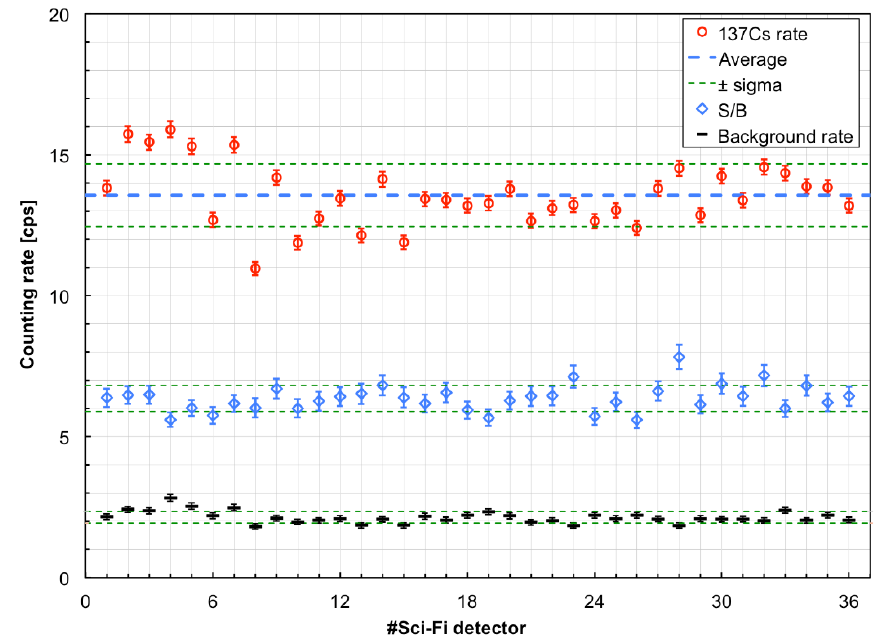
Figure 13. The counting rate of the 36 SciFi detectors, measured with the 137 Cs source in 200 s in the setup of Figure 12, along with the background rate and the signal-to-background ratio. The error bars represent the statistical uncertainty, the green dashed lines indicate ±1 standard devia- tions from the average.